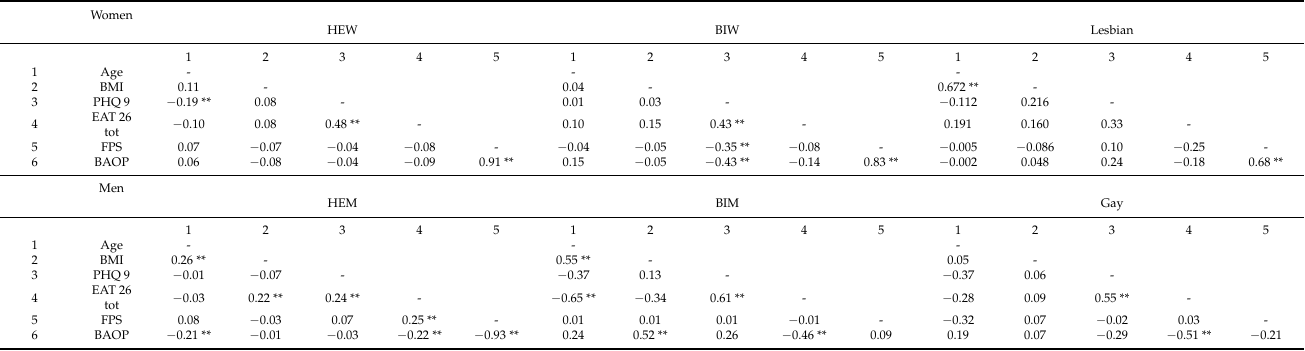
Table 3. Correlation analyses in different sexual orientation subgroups.